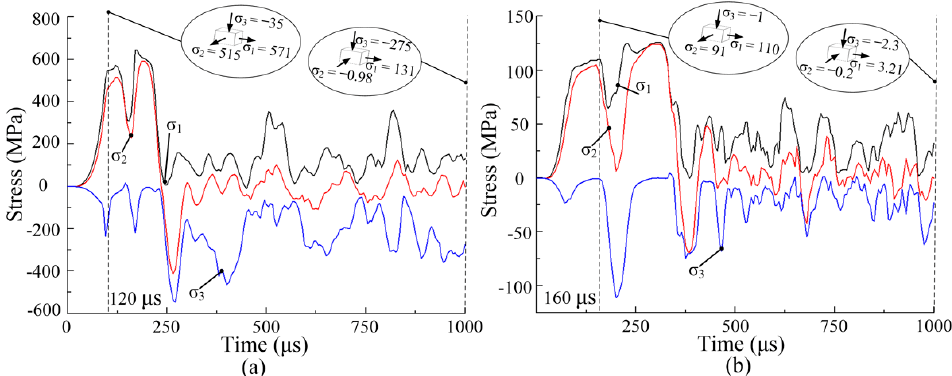
Figure 13. Variation of three principal stresses with time at node A during the forming process at different temperatures: ( a ) 200 °C; ( b ) 400 °C.